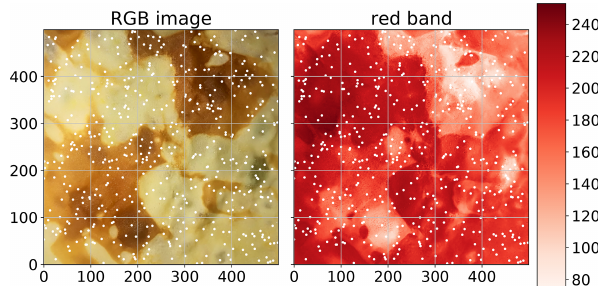
Figure 1. Original photograph of the pancake used to generate the pancake dataset. The white points indicate the 500 sampling loca- tions that were chosen randomly, without repeating. The observa- tion value is the red-channel value of the RGB value of the specified